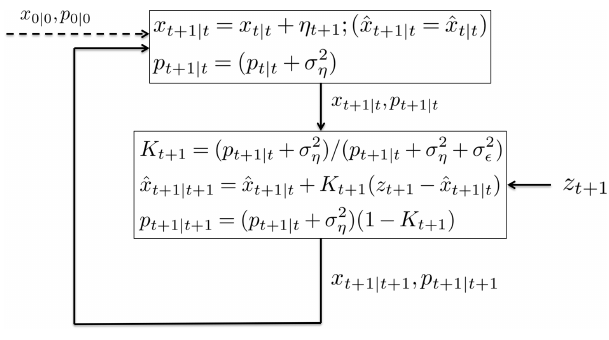
Figure B1. Workflow of the Kalman filter